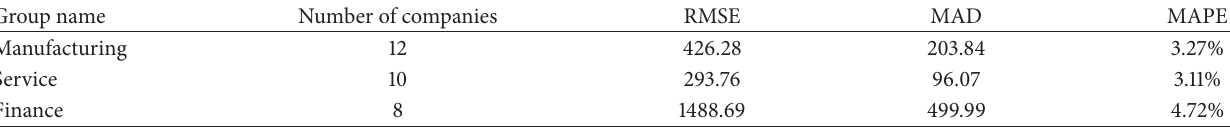
Table 3: The forecasting results of each group by using the single-SVR model.